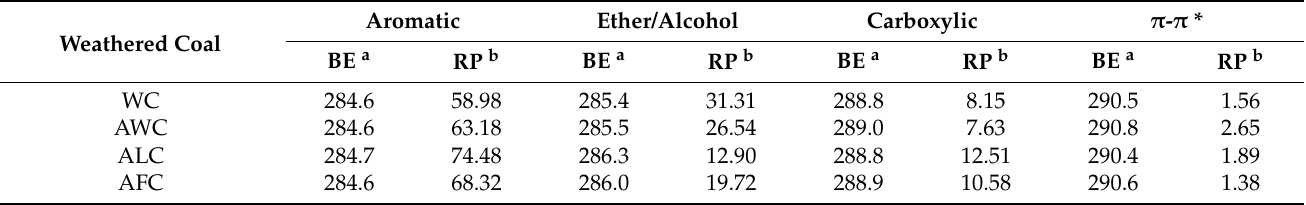
Table 2. Relative distribution of carbon functional groups in weathered coal humic acid determined by XPS.